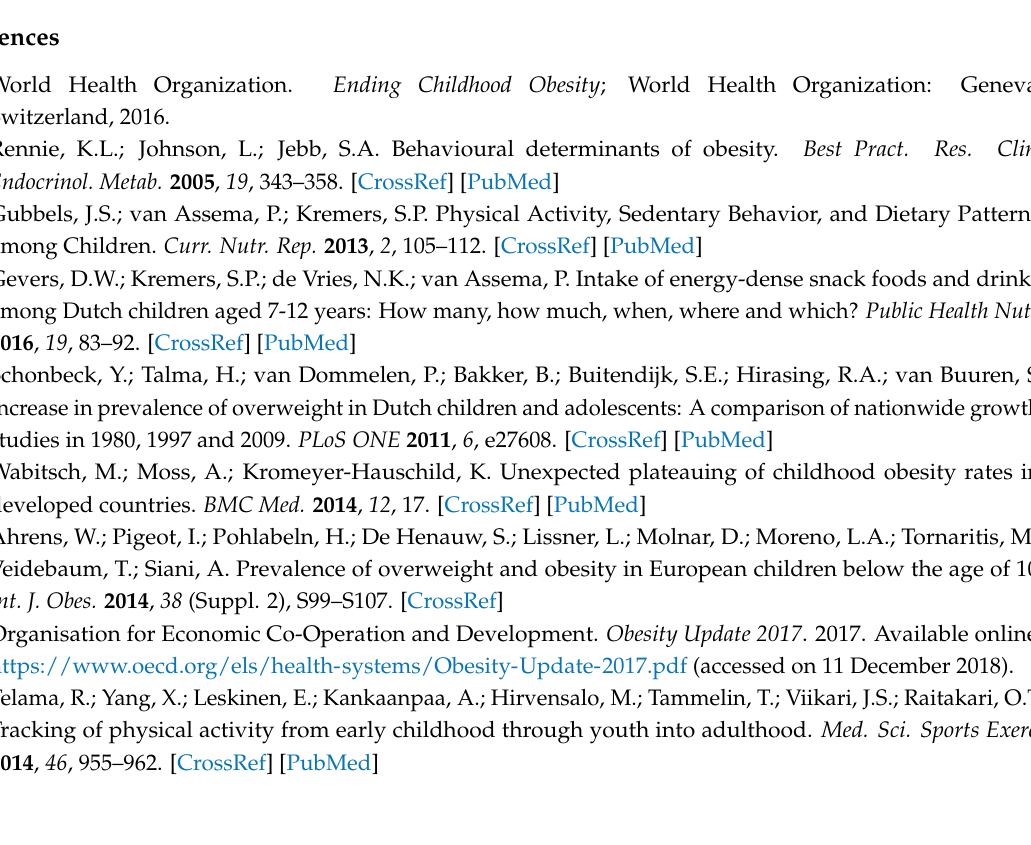
s1, Table S1: Concepts and quotes illustrating the concepts identified in the